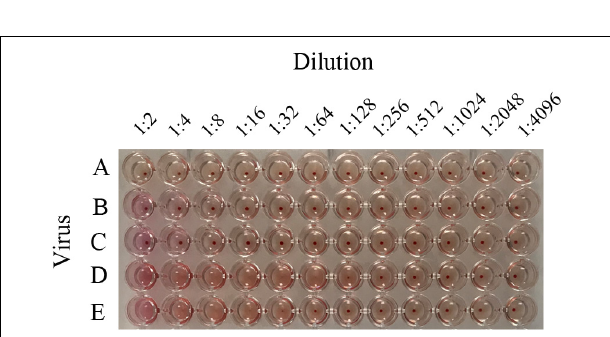
FIGURE 2 | Hemagglutination titers of H3N2 recombinant viruses. To figure out whether HA protein of LZP led to unable to bind the RBCs, the seven segments of LZP (NA, PB1, PB2, PA, NP, M, NS) were used as a backbone to rescue recombinant viruses (LZP-B10, LZP-HK4801, LZP-GMU03) bearing the HA genes of B10, HK4801, and GMU03, respectively. The recombinant viruses and LZP were determined by HA assay. A: PBS; B: LZP; C: LZP-GMU03; D: LZP-B10; E: